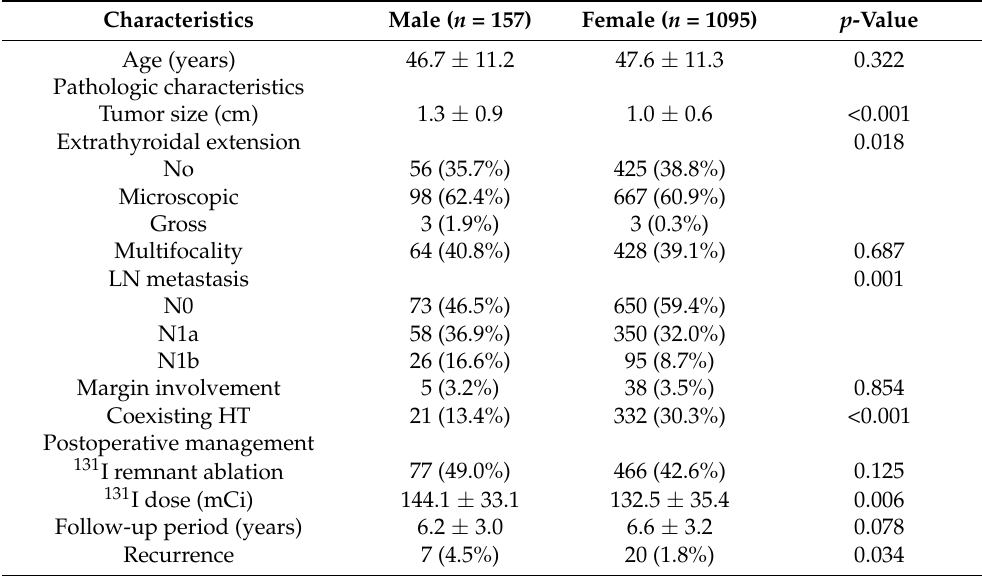
Table 1. Comparison of clinicopathological characteristics between male and female patients with papillary thyroid